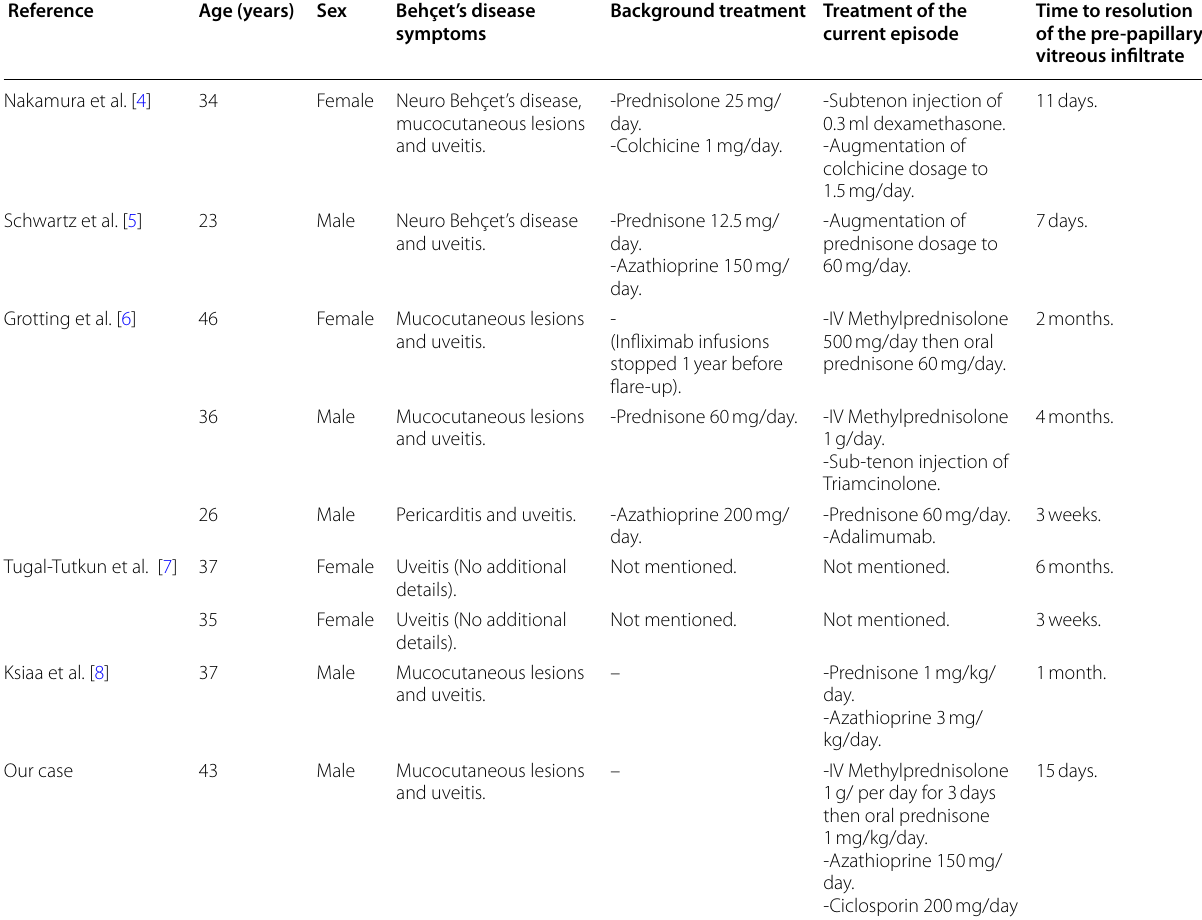
Table 1 Summary of the cases of Behçet’s disease uveitis associated with a pre-papillary vitreous infiltrate reported in literature